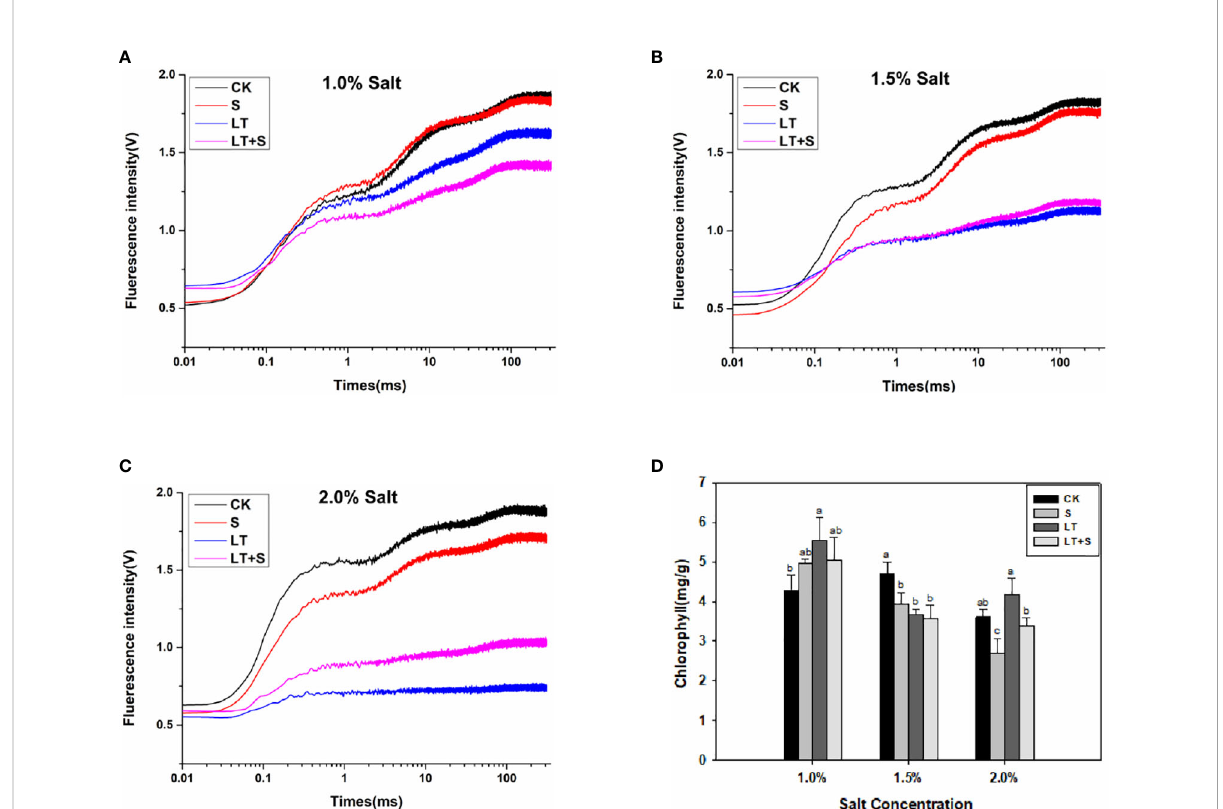
FIGURE 2 Effects of salt and cold treatment on photosynthetic parameters. (A – C) . Transient changes in chlorophyll fl uorescence in bermudagrass leaves under 1.0 percent (A) , 1.5 percent (B) and 2.0 percent (C) salt treatment. (D) Chlorophyll content. Different letters above the same columns represent statistically signi fi cant differences at P < 0.05 (Duncan ’ s multiple range